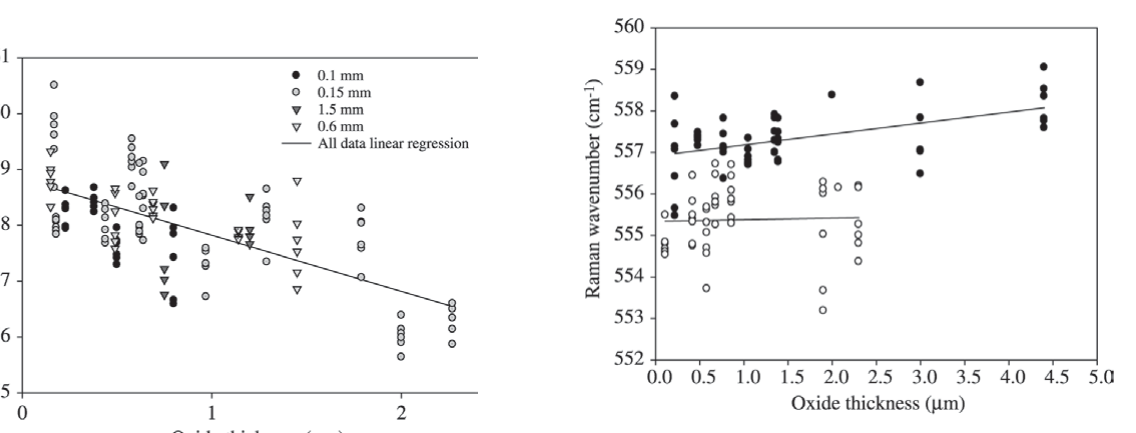
Figure 6. Evolution of the room temperature Raman wavenumber as a function of oxide scale thickness for oxides grown at 900 °C in O (open circles) or H O (black circles) on the reference grade 2 2